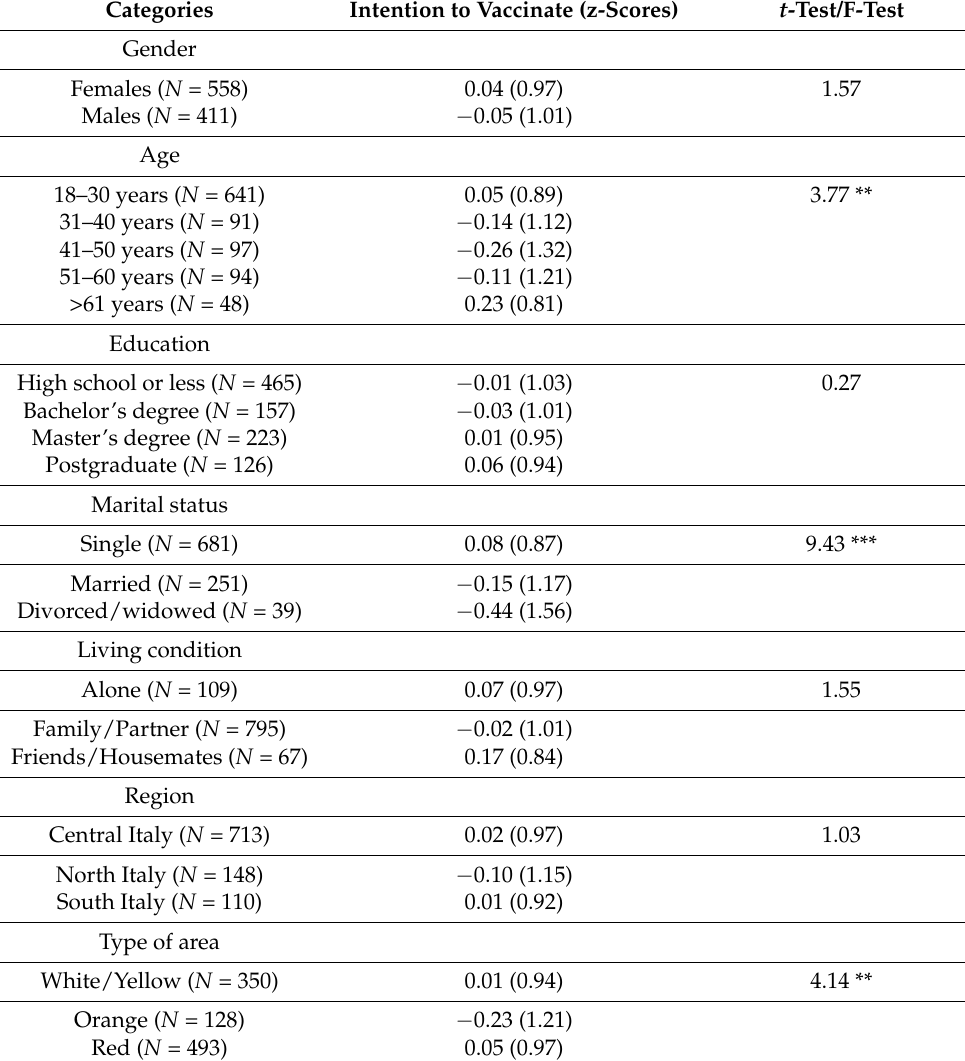
Table 3. Means (and standard deviations) for intention to vaccinate (z-scores), as a function of gender, age, education, marital status, living condition, region, and type of area, together with the results of statistical analyses ( t -test or F-test).